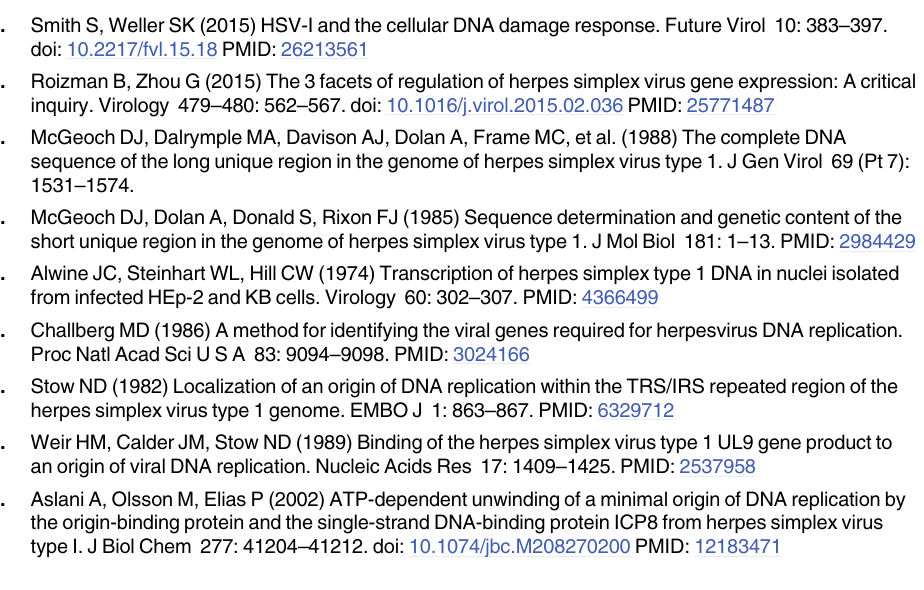
S1 Fig. Cellular DNA is Not Efficiently Labeled with EdC during Pulse Chase Experiments. S2 Fig. Viral Genome Dynamics during Pulse Chase Experiments. S3 Fig. Analysis of the Colocalization of Viral Replication Fork Associated Proteins with Pre-Replicative Viral Genomes at 2 hpi. S4 Fig. Analysis of the Colocalization of Viral Replication Fork Associated Proteins with Viral Genomes Blocked for DNA Synthesis.